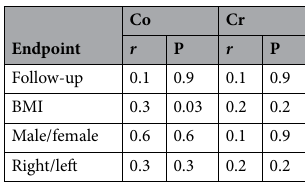
Table 4. Multiple linear